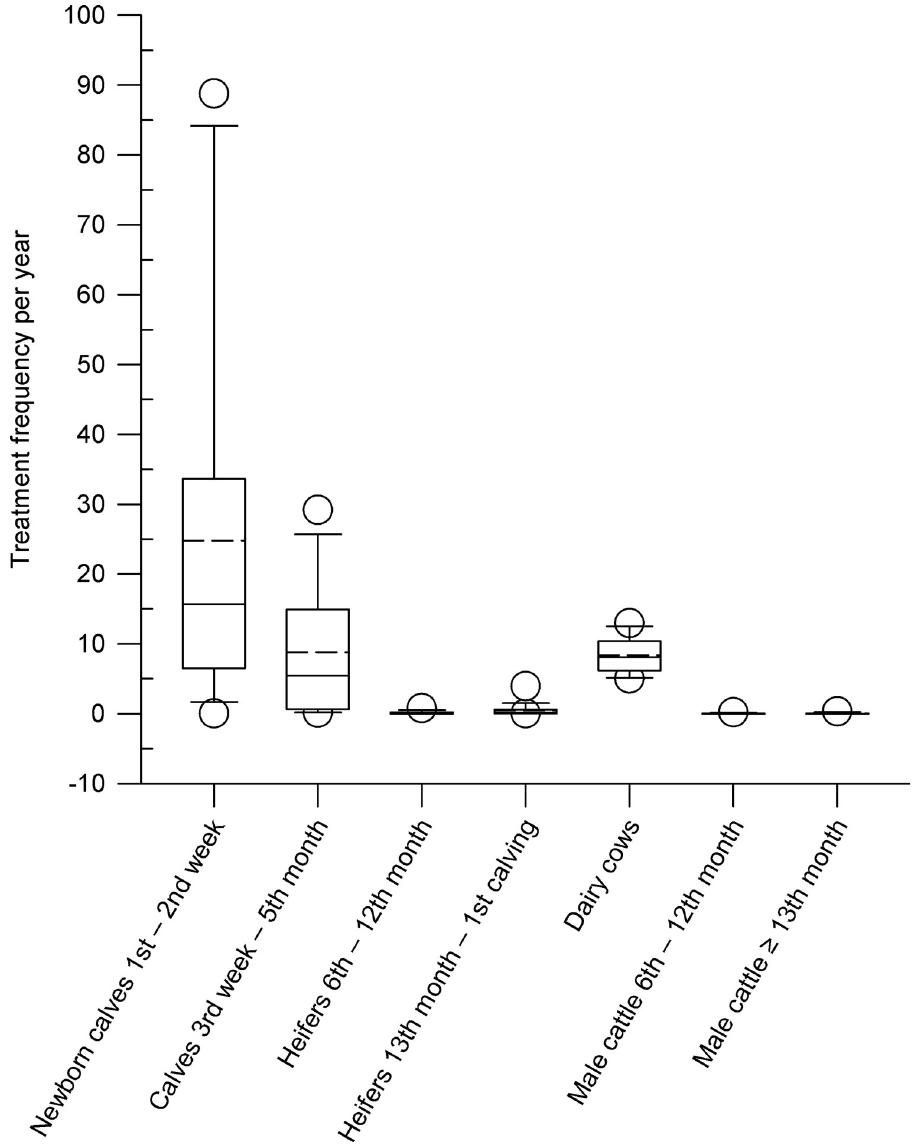
Fig 1. Treatment frequencies of the different age groups per animal and year on nine dairy farms. Box, the range between the 1 st (Q1) and 3 rd (Q3) quartile; horizontal line, median; dashed line, mean; circles, outlying points (5 th , 95 th percentiles,